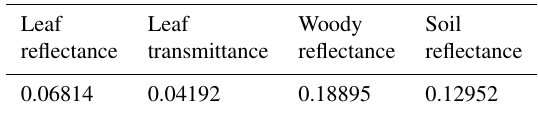
Table 2. Optical data in PAR domain used in the sensitivity analysis. Leaf Leaf